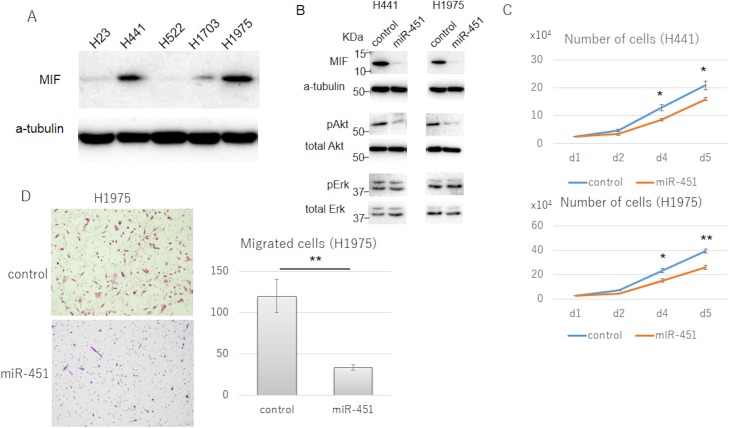
Macrophage migration inhibitory factor (MIF) expression of non-small cell lung cancer (NSCLC) cell lines and the effects of miR-451 mimic transfection of NSCLC cell lines.(A) MIF expression in NSCLC cell lines by western blotting. H441 and H1975 showed relatively higher MIF expression. (B) Western blotting of MIF, phosphorylated Akt (pAkt), total Akt, phosphorylated Erk (pErk), and total Erk of H441 and H1975 cells after miR-451-mimic (miR-451) and Mimic Negative Control (control) transfection. (C) Cell proliferation assay of H441 and H1975 cells after miR-451-mimic (miR-451) and Mimic Negative Control (control) transfection d: day, error bars: +/-SEM, *: P<0.05 (unpaired t-test), **: P <0.005 (unpaired t-test). (D) Cell migration assay of H1975 cells after miR-451-mimic (miR-451) and Mimic Negative Control (control) transfection. Migrated cell stained with Giemsa solution (left) and migrated cell counts (right). Error bars: +/-SEM, **:P<0.005 (unpaired t-test).